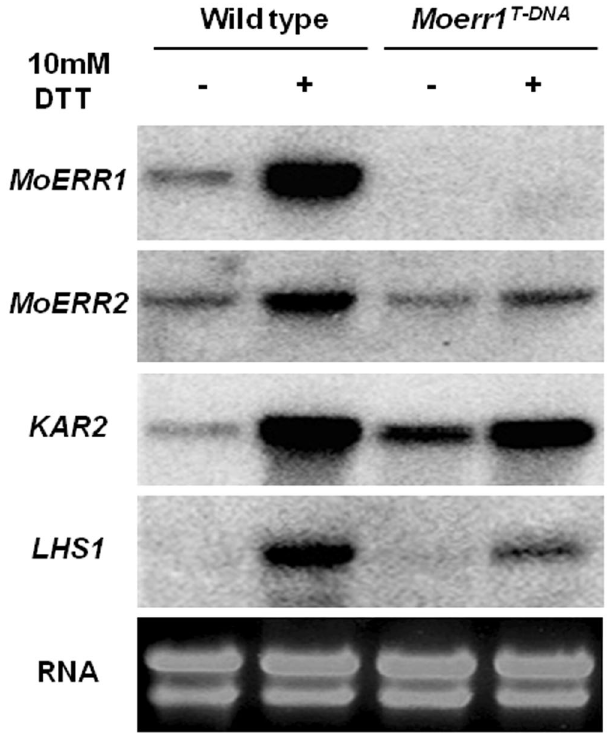
Figure 8. Gene expression of MoERR1 , MoERR2 , KAR2 and LHS1 under ER stress condition. Mycelia were grown on liquid complete medium for 3 days, and transferred to new medium. After incubation of 1 day, 10 mM DTT treatment for 30 minutes was used as ER stress condition. Partial cDNA fragment of MoERR1 , MoERR2 , KAR2 and LHS1 were used as probes of northern blot analysis. Blot and gel images were cropped for better